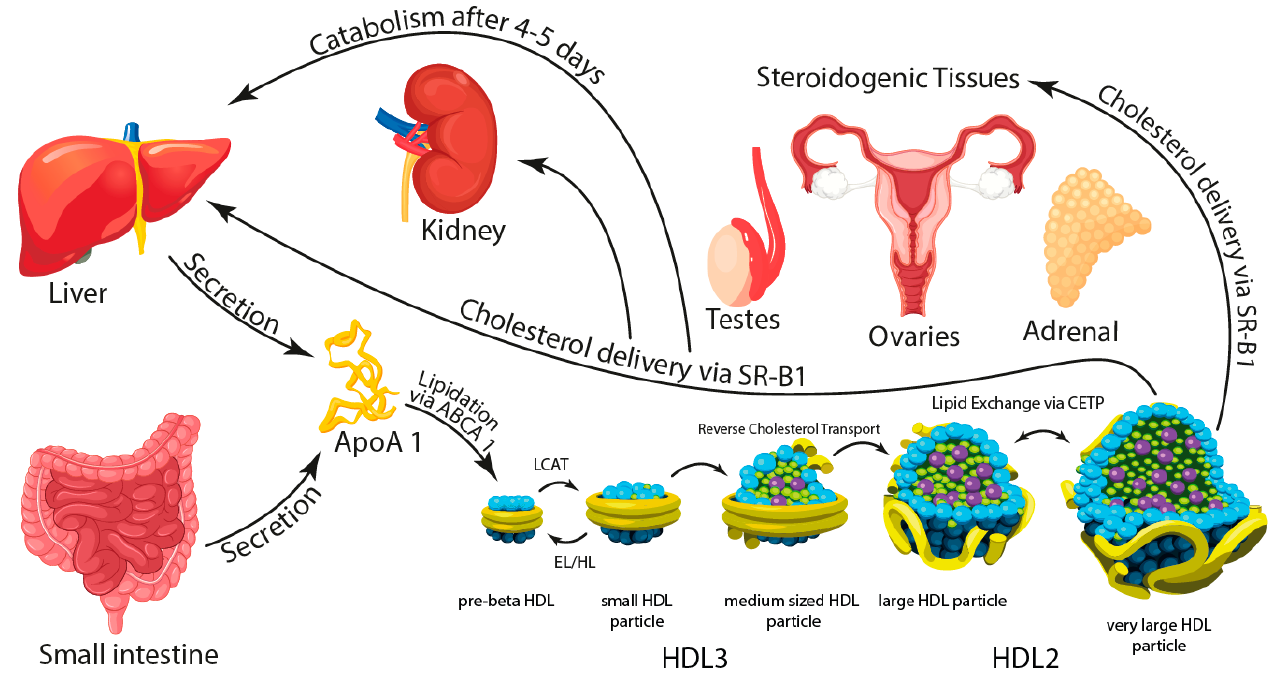
Figure 1. Apolipoprotein A-1 (ApoA-1) is synthesized in the liver and the intestine and secreted in a lipid-free state. Assembly of the HDL particle begins with the lipidation of the ApoA-1 protein via ABCA-1 cholesterol efflux, creating a discoidal shape termed pre- β HDL. Lipidation of pre- β HDL via LCAT results in the formation of small, spherical HDL particles. Further re-modelling of the HDL particle is a complex metabolic process that involves several enzymes. The HDL particles may grow in size by accumulating cholesterol and other lipids from peripheral tissue, a process termed reverse cholesterol transport (RCT), widely considered to be the main function of HDL. HDLs may shrink in size by delivery of cholesterol and lipids to steroidogenic tissue via Scavenger Receptor-B1 (SR-B1), peripheral tissue and the liver via endothelial (EL) and hepatic lipases (HL), or lipid exchange via CETP to apoB-containing lipoproteins. After a 4-to-5-day life cycle HDLs are permanently catabolized in the liver or kidneys.